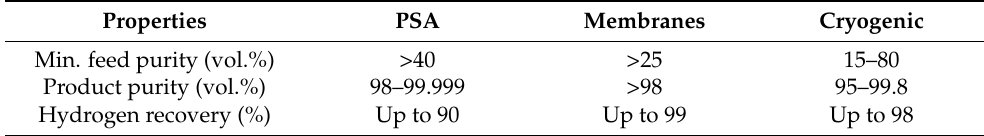
Table 3. Properties of different hydrogen purification processes (adapted from Refs